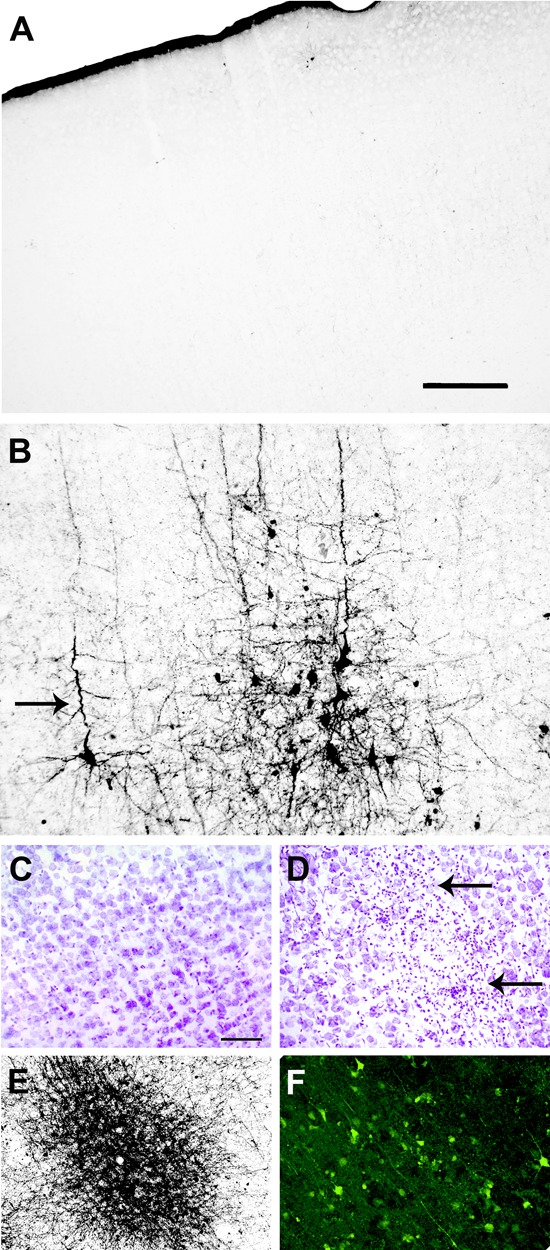
Infection with SLEV CbaAr-4005 induced exitotoxic-like degeneration in cortical structures of mice sacrificed at day 11 PI. Compared to the brain of uninfected mice (A), the motor cortex from the brain of infected mice presented various degenerating patterns, with neurons with golgi-like appearance with smooth contours, homogeneous impregnation of the cell bodies and corkscrew dendritic arbors (arrow), surrounded by apoptotic-like neurons (B); Bar = 50 μm. Consecutive sections of brains of control (C) and infected (D) mice, stained with Nissl, A-Cu-Ag (E) and Fluoro-Jade B (F), also evidenced degeneration with cell loss and gliosis (small arrows). Sagittal sections Lat 2.10, Bar = 50 μm. This figure is representative of three independent experiments.